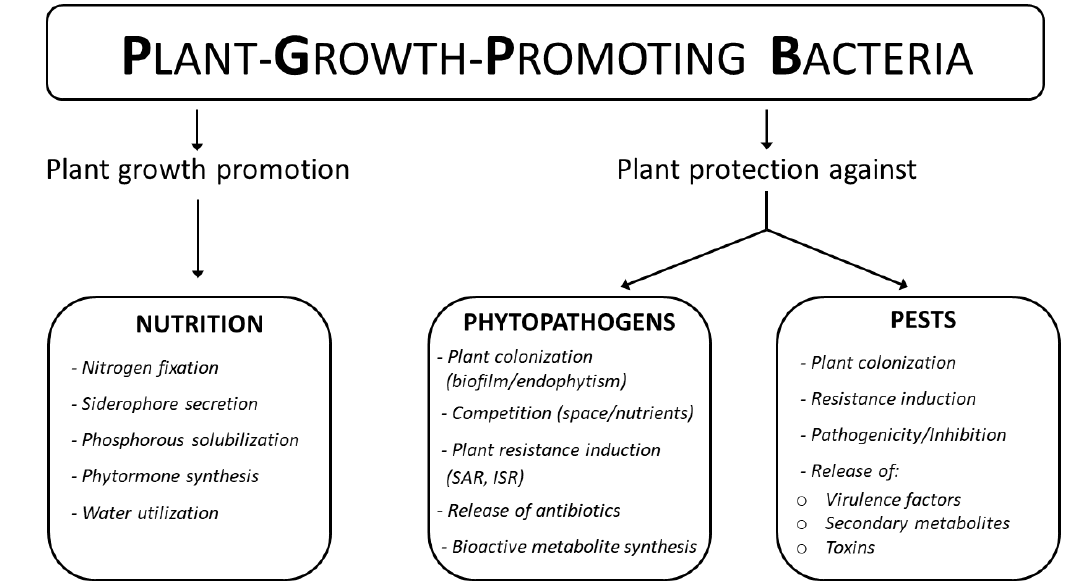
Figure 1. Representative scheme of the multiple utilities of some soil-dwelling bacterial species and their main mechanisms of action.